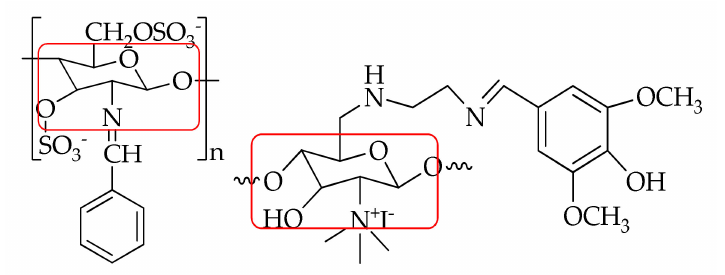
Figure 3. Anticancer activity of chitosan